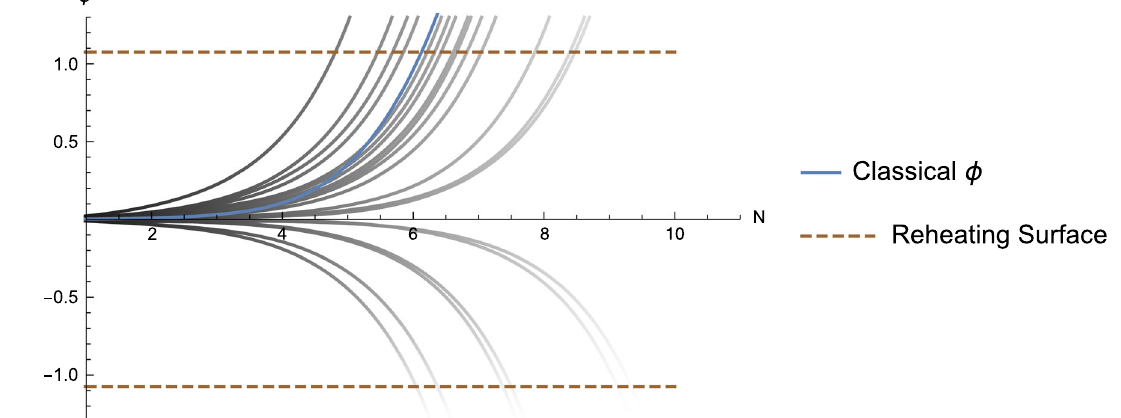
Fig. 2 Time evolution of the scalar field once it exits the region of eternal inflation. The horizontal axis is time as measured in terms of e-folding number, the vertical axis gives the field value in Planck units. The bue curve (the one that hits the upper dashed line the fifth from the left)istheresultoftheanalyticalcalculationusingtheslow-rollapprox- imation.Theothercurvesshowtheresultsof100numericalsimulations